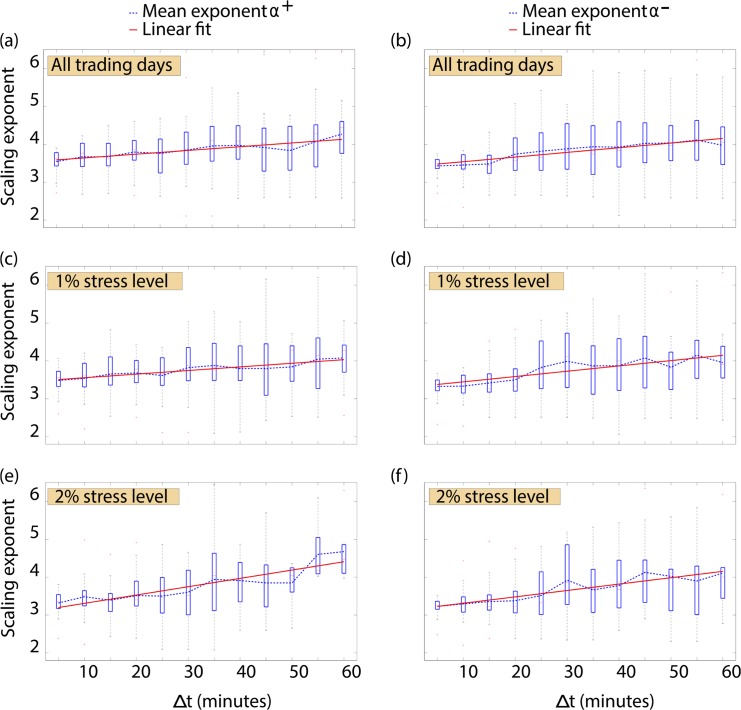
Relationship between Δt and the scaling exponent for the empirical tails of return distributions.(a) We investigate the relationship between the time lag between price observations used to build the returns distribution and the scaling exponents of the tails of distributions. We consider here the tails of the positive component of the distributions obtained when analyzing all trading days present in our dataset. We find that the mean scaling exponent increases as Δt increases (Adjusted R
2 = 0.802, N = 12, p < 0.001, ordinary least squares regression) (b) In a similar fashion, we observe that when analyzing all trading days the mean scaling exponent for the tail of the negative component of the distributions increases with the time lag (Adjusted R
2 = 0.839, N = 12, p < 0.001, ordinary least squares regression) (c) We now restrict our analysis to trading days on which the prices of stocks have changed by more than 1%. We find that the mean scaling exponent of positive tails consistent with power law behavior increases with Δt (Adjusted R
2 = 0.856, N = 12, p < 0.001, ordinary least squares regression) (d) Under 1% stress, an increase in the time lag Δt results again in an increase of the mean scaling exponent for the tails of the negative returns distributions (Adjusted R
2 = 0.729, N = 12, p < 0.001, ordinary least squares regression) (e) We now perform the same analysis for days on which the prices of stocks have changed by more than 2%. The mean scaling exponent for the tails of the positive component of the distributions again shows an increase with increasing Δt (Adjusted R
2 = 0.782, N = 12, p < 0.001, ordinary least squares regression) (f) Similarly, the mean scaling exponent for the tails of negative returns distributions at the 2% stress level increases as the time lag Δt between price observations increases (Adjusted R
2 = 0.836, N = 12, p < 0.001, ordinary least squares regression).